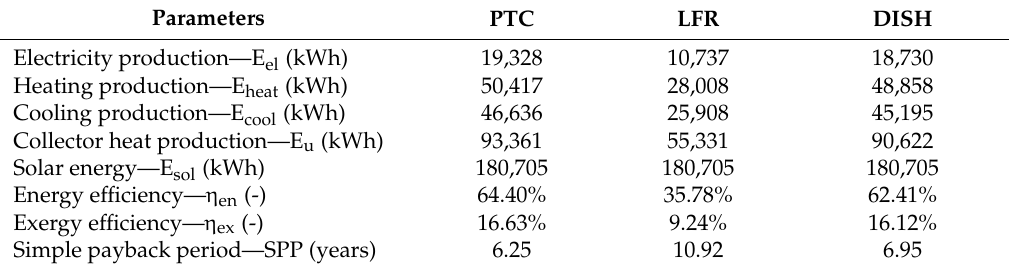
Table 4. The final comparative results of the present